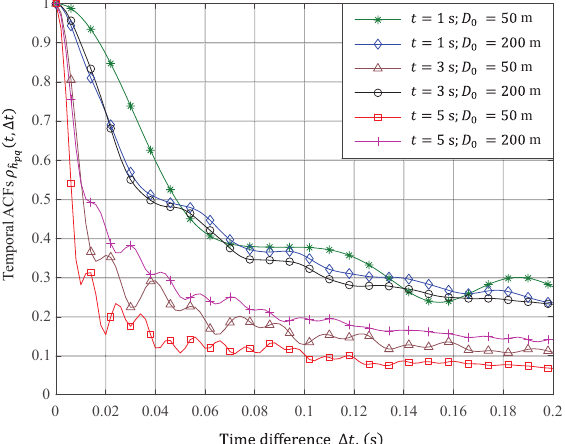
( t , ∆ t ) of non-WSSUS channel models for V2V communica- Figure 11. Estimated temporal ACFs ρ ˆ h pq tions with respect to the moving time of the MT and MR when Ω =